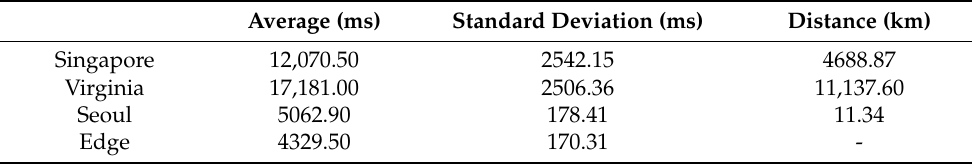
Table 3. Average and standard deviation of the AR content load on cloud servers.